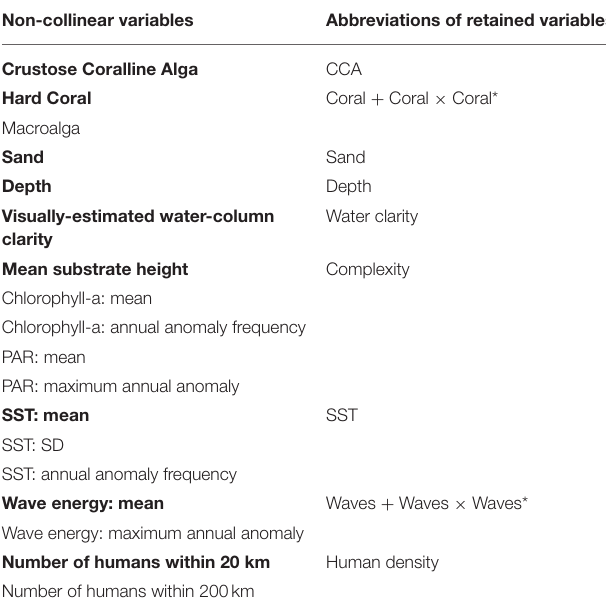
TABLE 2 | List of all non-collinear variables, with those in bold retained in the final model, and their abbreviations in the manuscript. Non-collinear